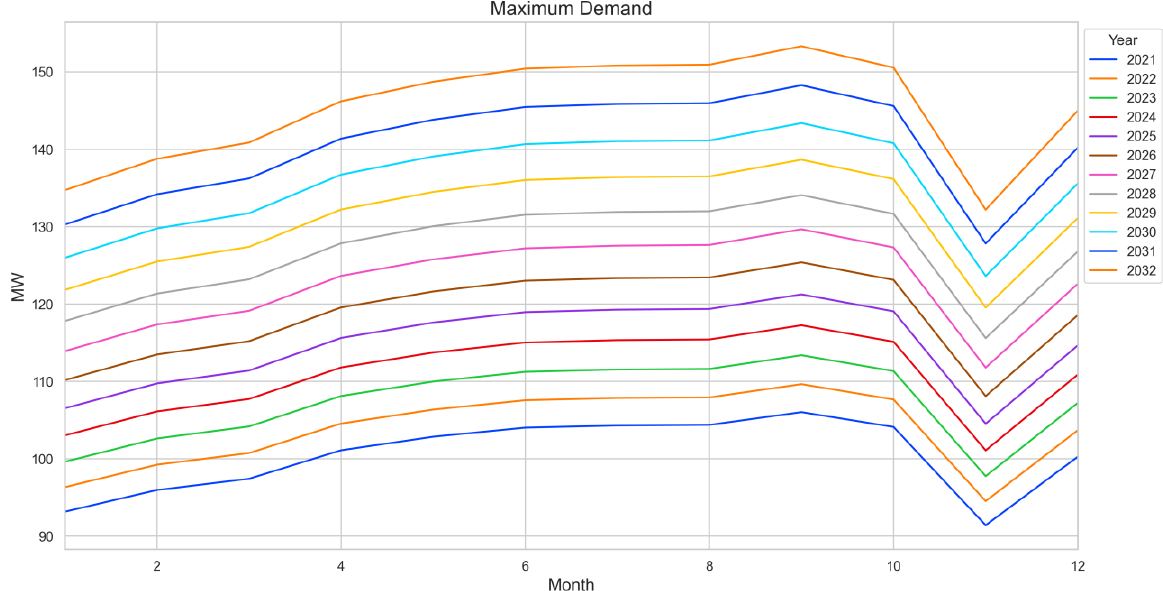
Figure 8. Growth of demand considering a high-projection future from 2017 to 2030.